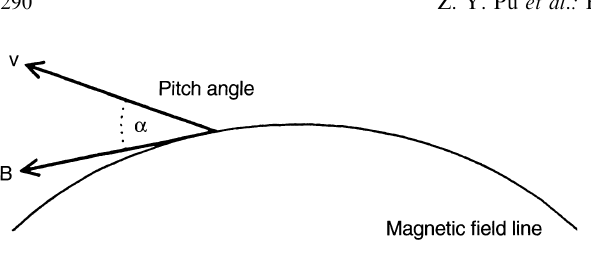
Fig. 5. Definition of pitch angle (cid:97)